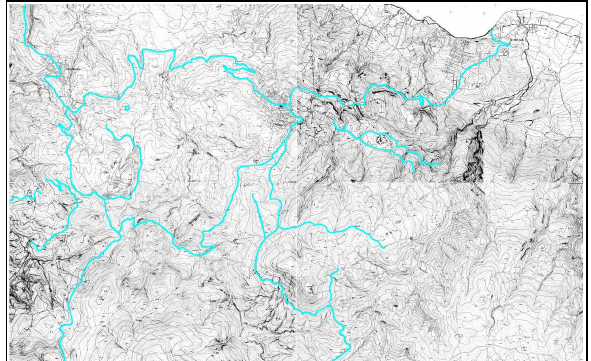
Figure 3. The 3D road network (GCLFs) on the old